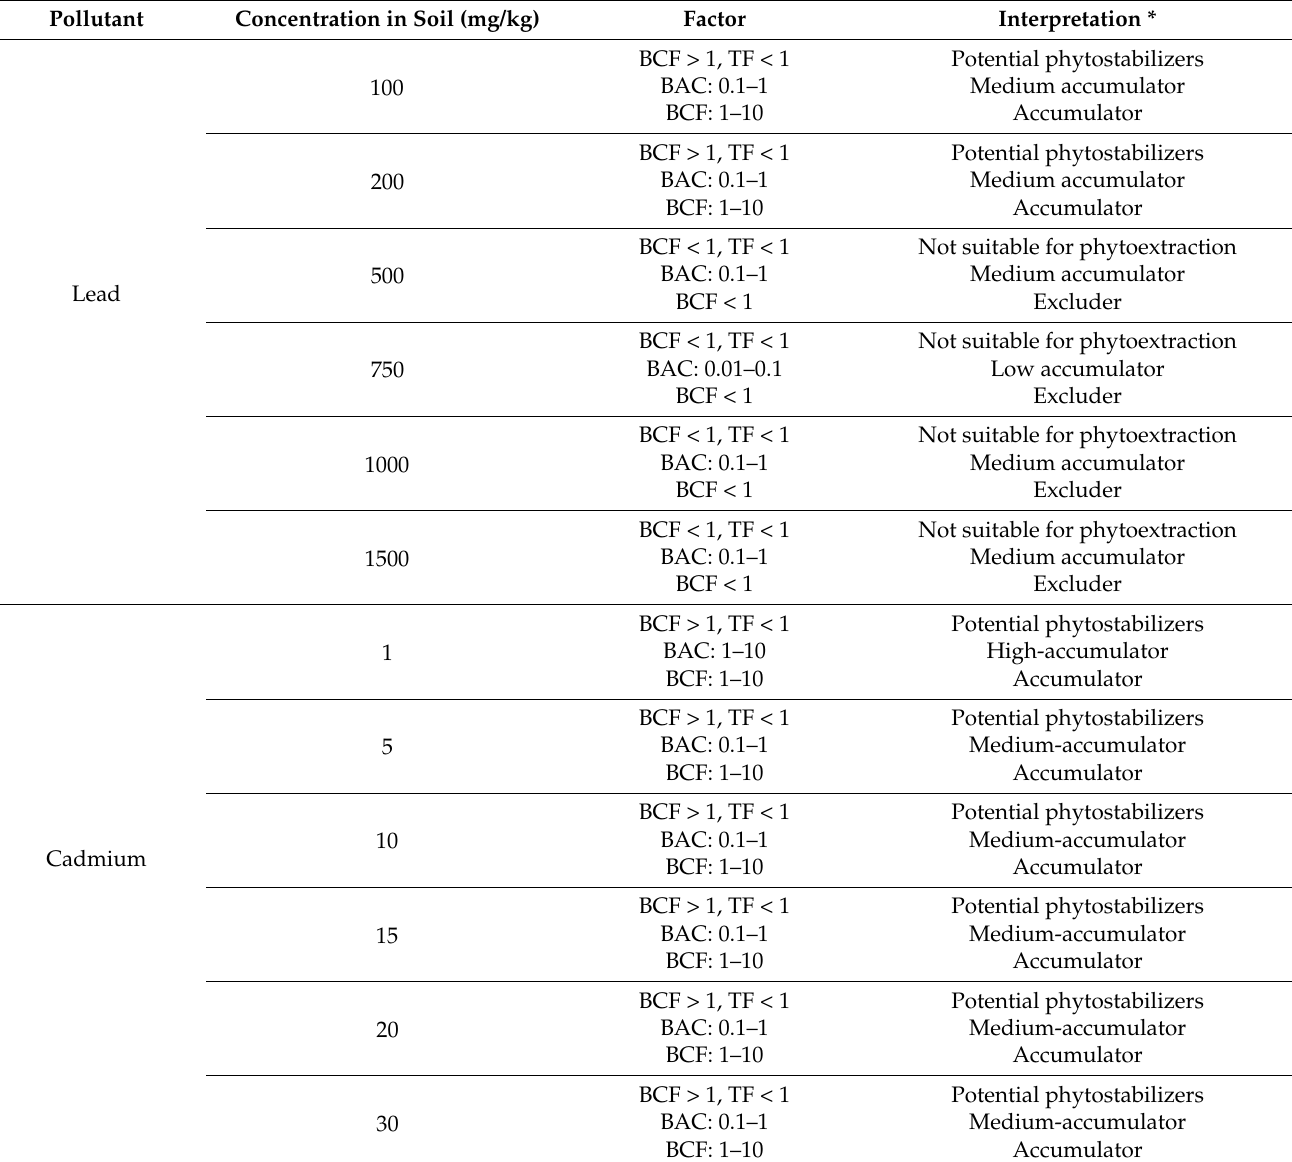
Table 3. Results and interpretation of phytoremediation potential of Brassica napus